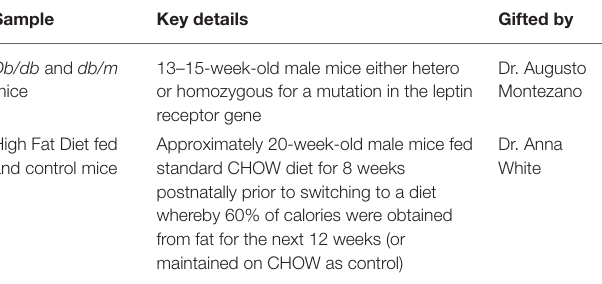
TABLE 3 | Information regarding primary cardiac